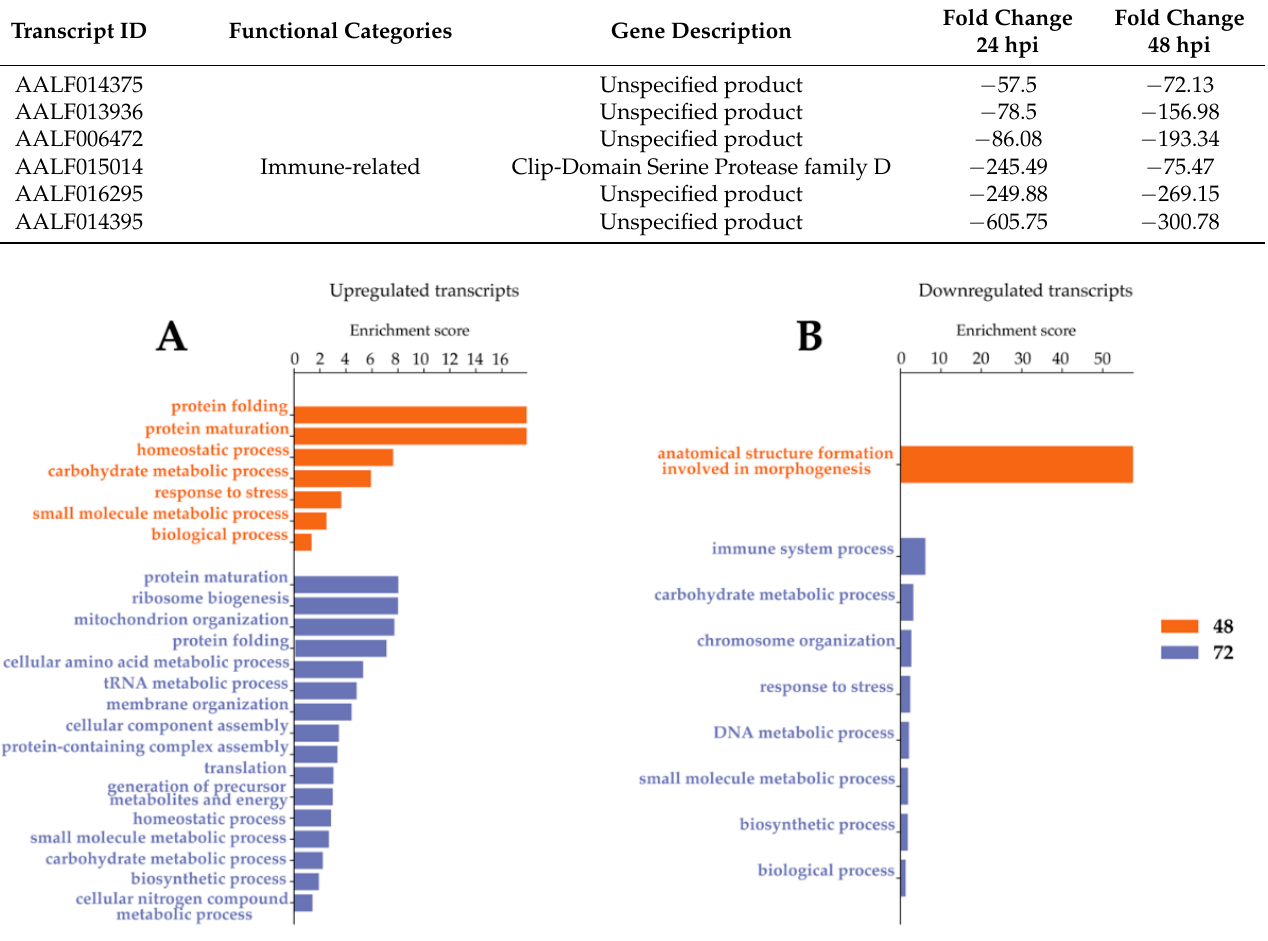
Figure 7. Gene ontology enrichment analysis for biological processes after LamV and WNV infection. ( A ) GO slim terms for up-regulated transcripts. ( B ) GO slim terms for down-regulated tran- scripts .